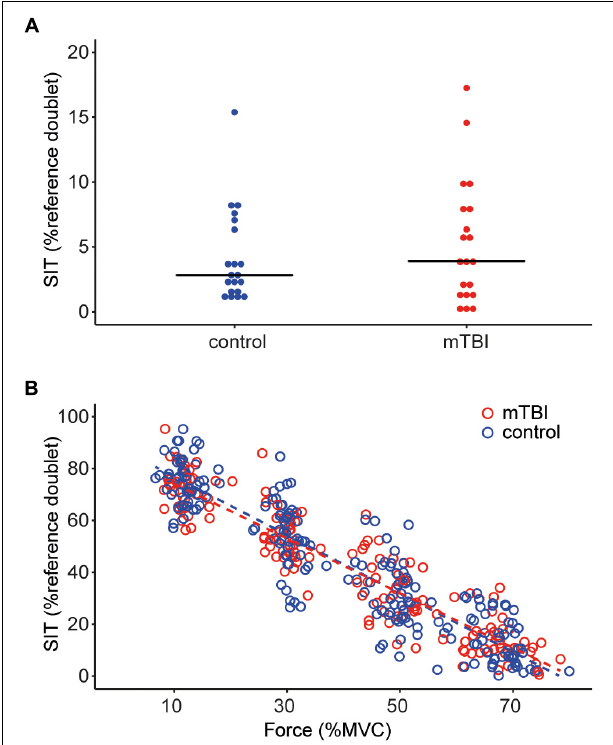
FIGURE 2 | (A) Dot plot showing the size of the superimposed twitches during the maximal voluntary contractions in task 1, values are rounded to the nearest 0.5%. The horizontal line indicates the median for the control participants (blue dots) and mTBI participants (red dots). (B) Superimposed twitches evoked during the submaximal contractions (at 10, 30, 50, and 70% MVC) in task 2. Control data is shown in blue, mTBI in red. A linear regression line is shown for both groups, but no significant differences were observed between control and mTBI participants. SIT, superimposed